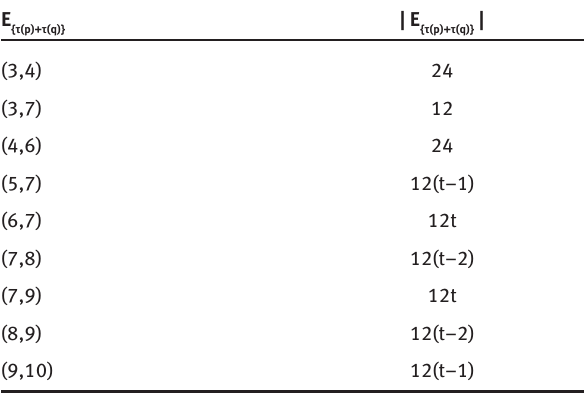
Table 6: The partation of the edges of MOF degrees addition of the leap neighbors of end nodes.